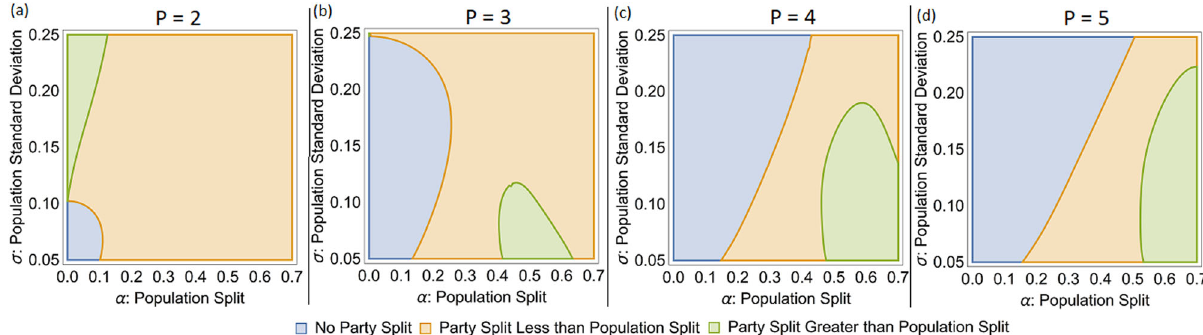
Fig. 7 Sets of model parameters where Q = 30 and R = 5, and P takes on values from 2 to 5. As P increases, the voter choice model gives more weight to “ pragmatic" main party opinions, and the mapping between ideological distribution and the relative political position of the two main-parties changes. When P is lower, political parties diverge under most ideological distributions, but only more than the public itself when there is high variance around two otherwise close ideological centers. When P is higher, parties converge to the middle when the population split is low, and are more polarized than the electorate when the population split is large, but the variance around the two ideological centers is